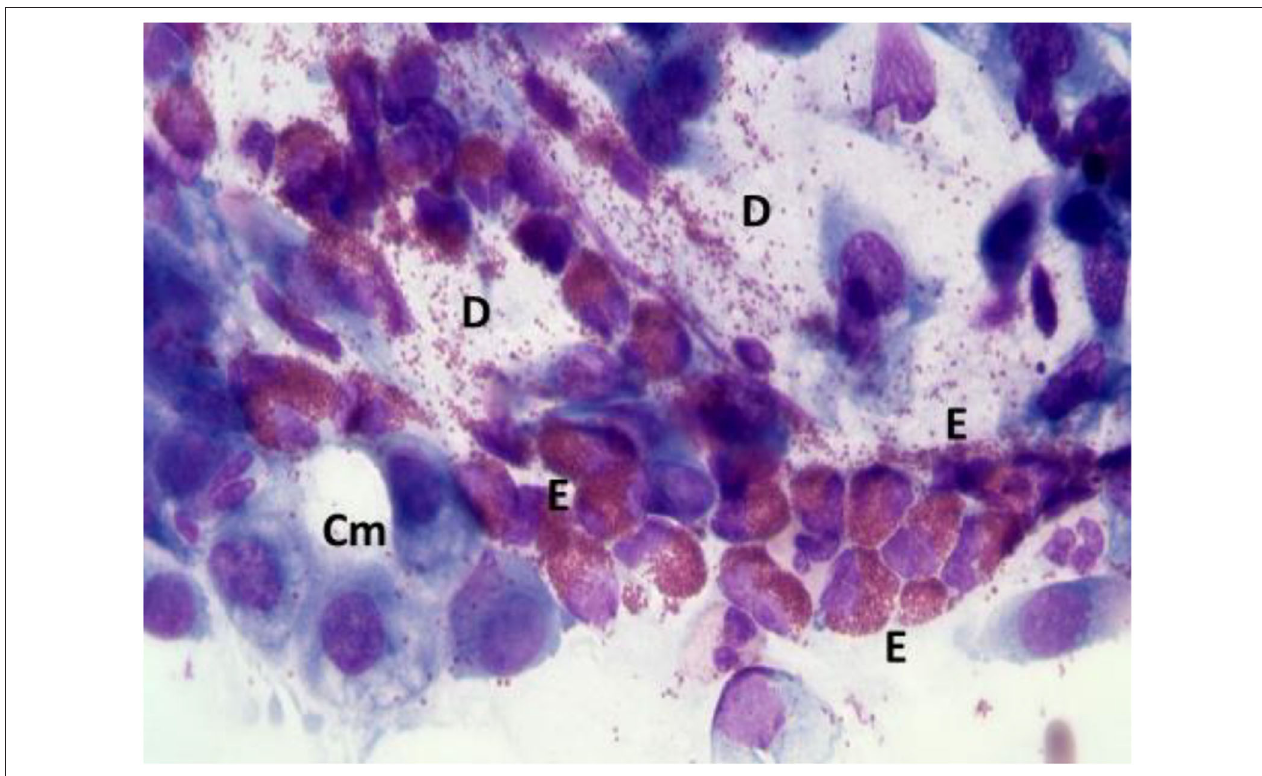
FIGURE 1 | Nasal cytology of NARES. E, eosinophil; D, degranulation; Cm, calicifom mucous cells. MGG staining. Magnification 1000x.